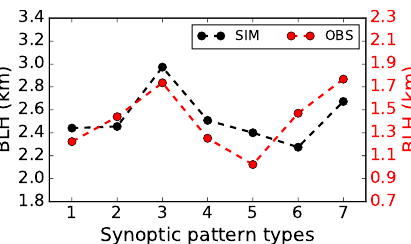
Figure 10. The simulated BLH at 14:00BJT (in black) and ob- served BLH at 14:00BJT (in red) over Beijing were shown as a function of synoptic types.